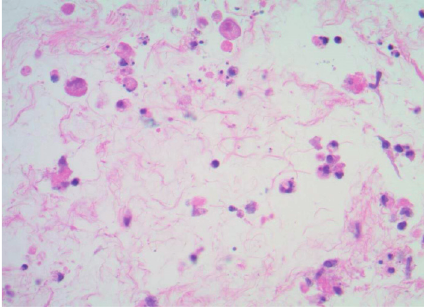
Figure 2: Individual cell necrosis with viral cytopathic effect seen in the subamniotic umbilical cord stroma (hematoxylin and